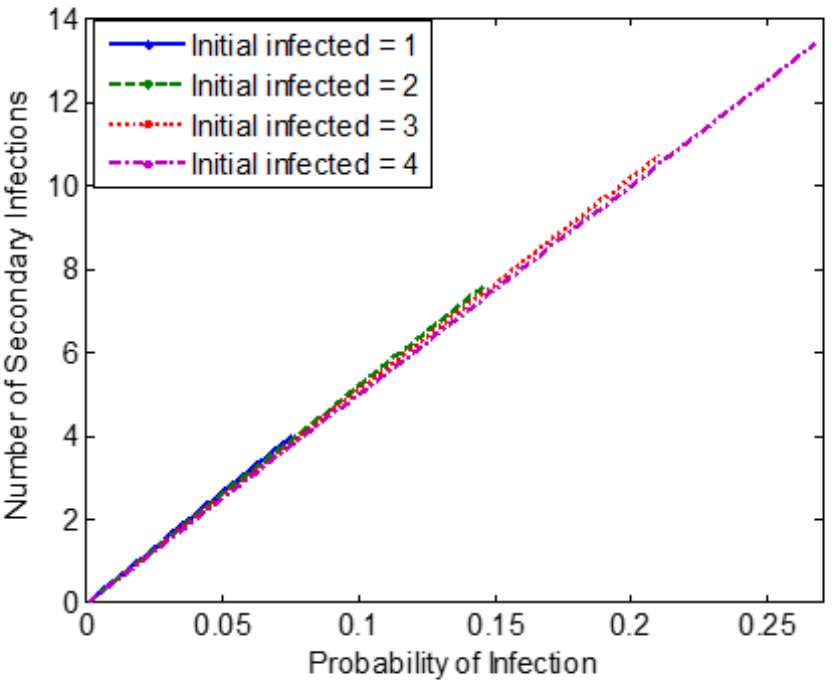
Figure 9. The number of secondary infections in the train compartment due to the introduction of infected individuals into the susceptible population (total population of N = S + I = 54), shown as a function of the estimated probability of infection.